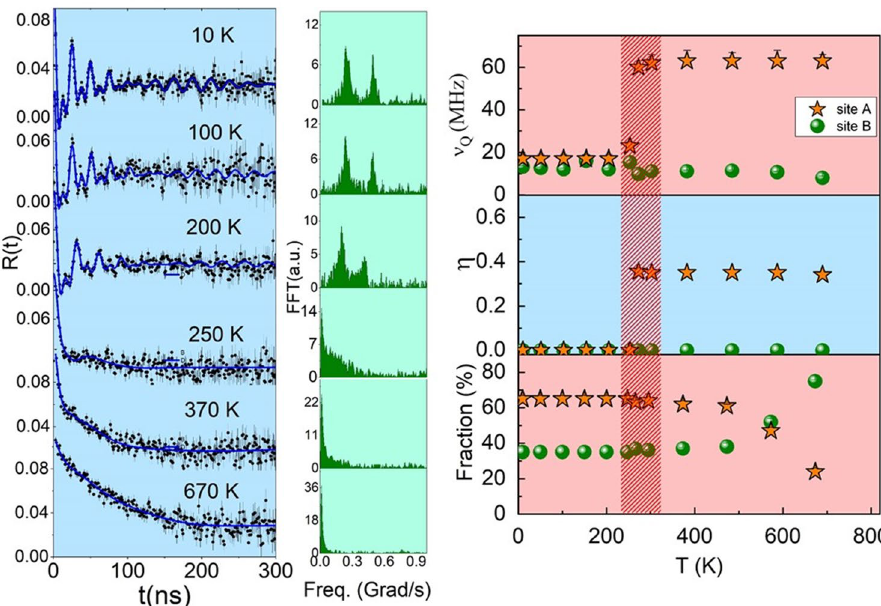
111 Cd in sample S2 111 Cd probes. Arrow lines are